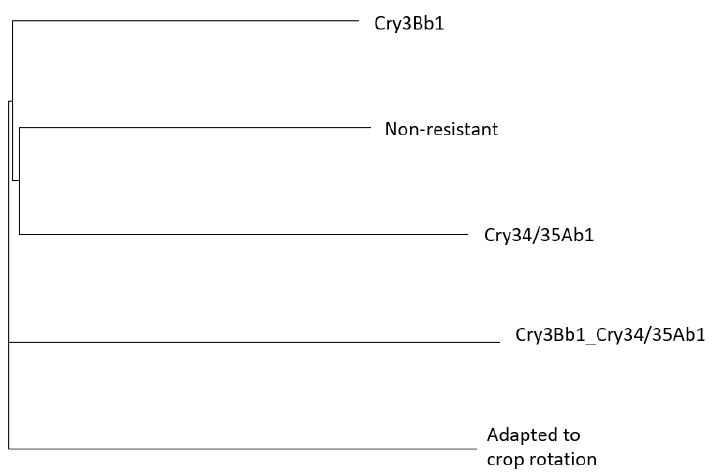
Figure 6. The neighbor-joining cluster analysis using DArTseq SNP markers for grouping 29 WCR genotypes.